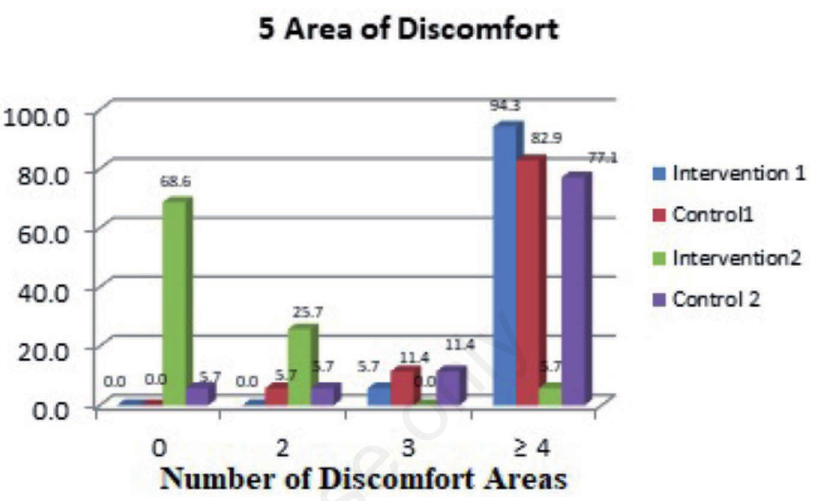
Figure 2. Frequency distribution based on the area of maternal discomfort in the prelim- inary and final assessments of the intervention and control group. 0= Comfortable; 2=